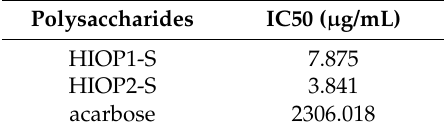
Table 2. The IC50 of H1OP1-S and H1OP2-S.